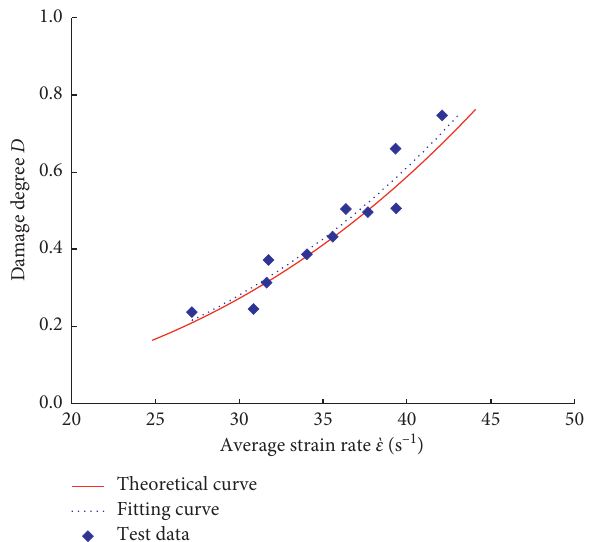
Figure 8: Relationship between the average strain rate and the degree of damage for P